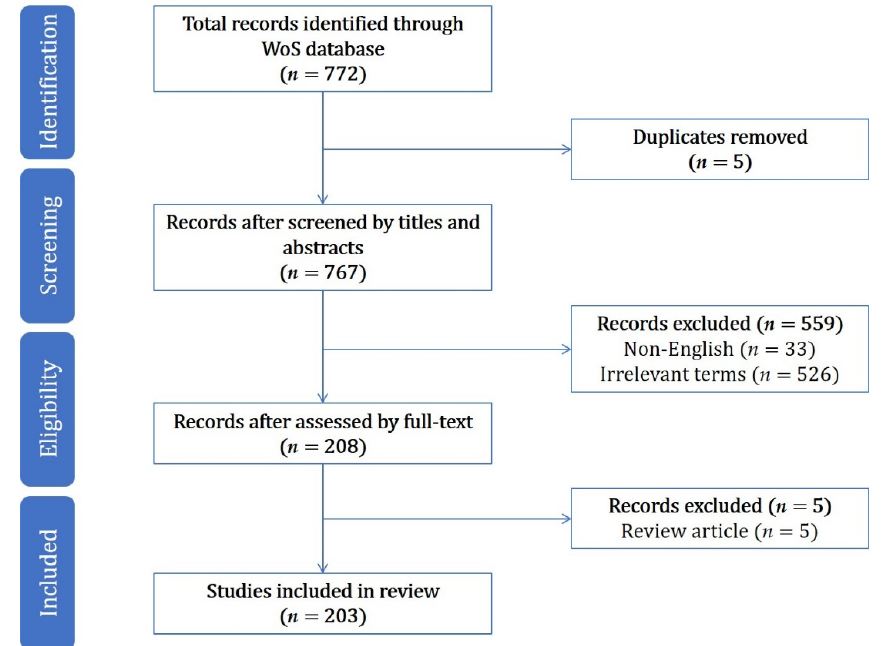
Figure 1. Article search and screening process.